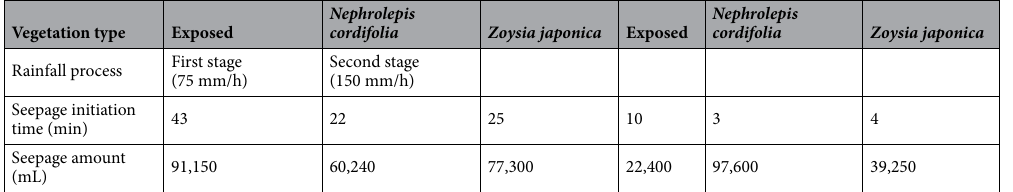
Table 5. Rainwater seepage comparison.